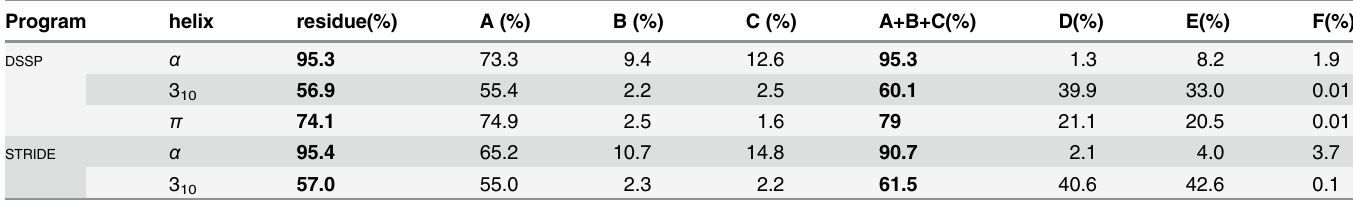
Table 5. The comparisons of helix assignment on N by our algorithm, DSSP and STRIDE . The third column (in boldface) is the agreement on a residue where N is the total number of residues assigned by our program, and n the number of the residues assigned by both our algo- basis computed as 100 : 0 (cid:5) n N rithm and either DSSP or STRIDE . The agreement on a residue basis on π -helix assignment between our algorithm and STRIDE is very poor, only 2.9%. The 4th- 10th columns present various agreements (disagreements) on a helix basis. The columns A, B, C show respectively the agreement with at most one residue difference, with the exclusion of the N-terminal residue and the exclusion of the C-terminal residue. The column A+B+C (in boldface) sums up the agreements on a helix basis. The next two columns D and E present respectively the helices assigned only by our algorithm and the helices assigned only by either DSSP or STRIDE . The last column F shows the set of helices each one has been assigned by either DSSP or STRIDE as a single helix but is divided into at least two heli- ces by our algorithm (see Figs 4 and 5). All the data are in percentage.